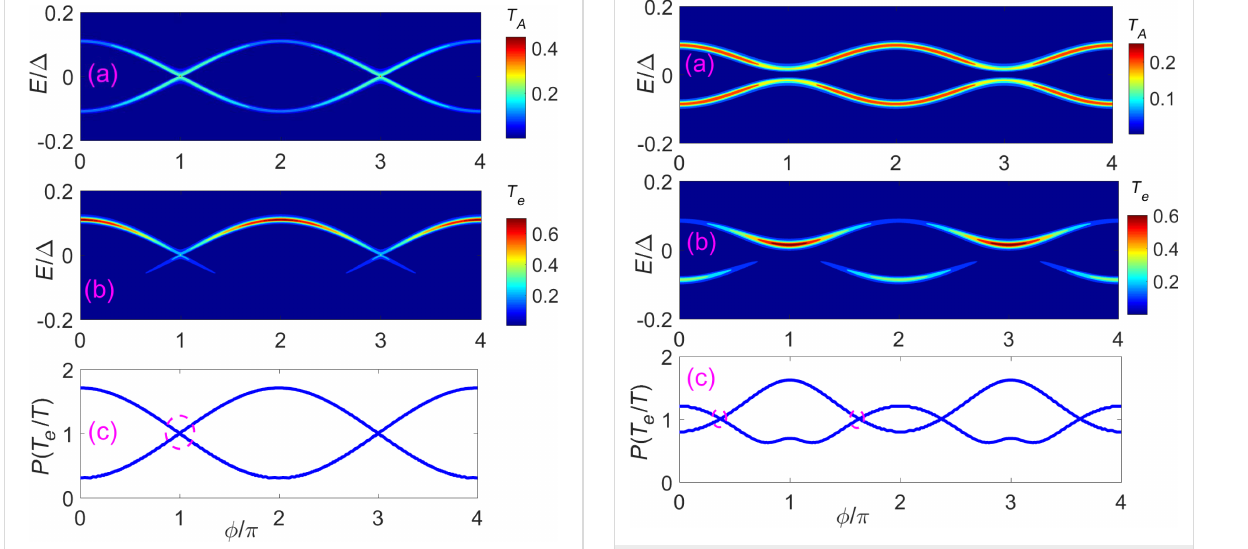
Figure 5: The case for two accidentally touching Andreev bound states. (a) Contour plot of the Andreev Reflection coefficient T A as a function of flux and the incident energy E . (b) Contour plot of the electron tunneling coefficient T e from the STM lead 1 to the STM lead 2 as a funciton of the flux and the incident energy E . For both cases, the period is 2 π . (c) The ratio between the peak value of T e and the peak value of T , here T = ( T e + T A )/2. They yield similar information as the DOS for the trivial states. The obvious characteristic is that they will intersect an even number of times or not at all in a 2 π period as in- dicated by dashed circles. The parameters are N x = 200 a , μ = − 2 t + 5.7 Δ , and V x = 2 Δ